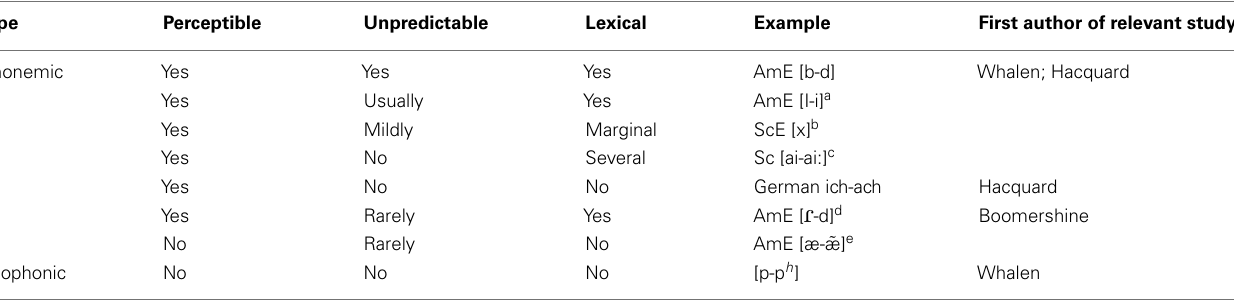
Table 1 | Perceptible: native speakers report hearing the difference; Unpredictable: the phone cannot be predicted by its phonological context; Lexical: there are many examples of minimal pairs sustaining the